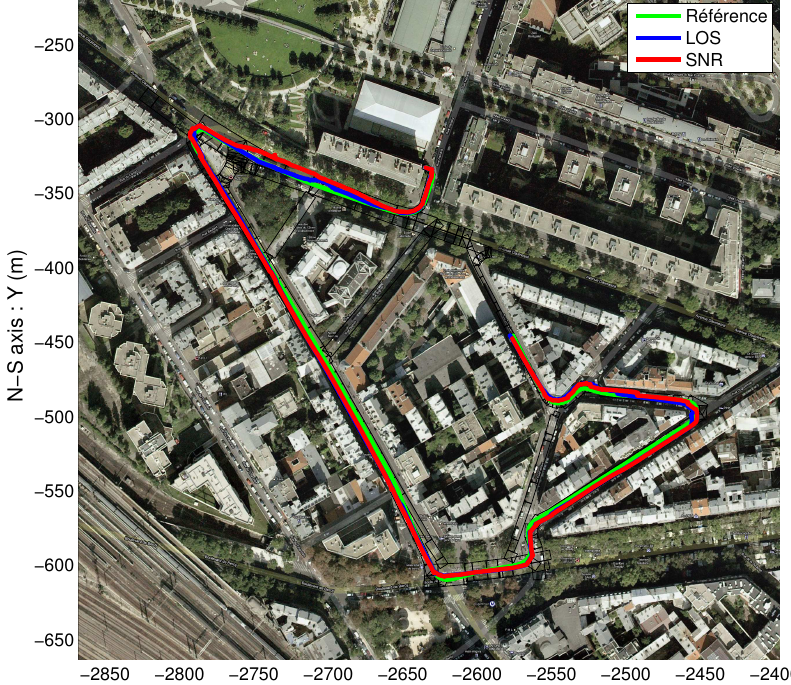
Figure 13. 2D overview of map-aided solutions for both